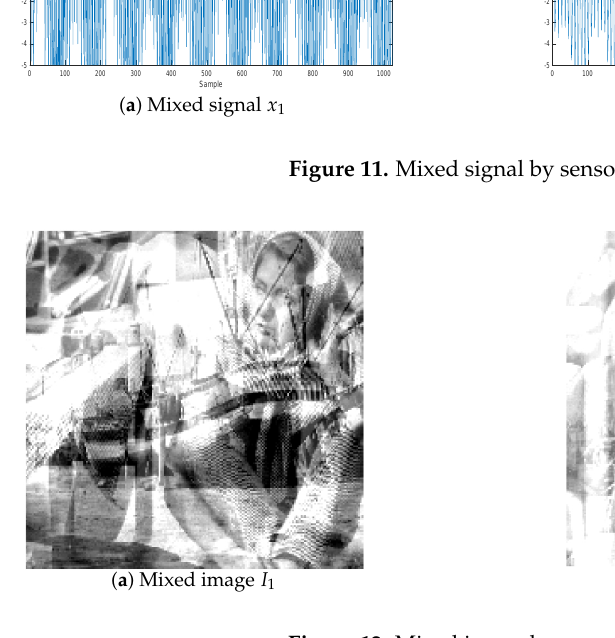
Figure 12. Mixed image by